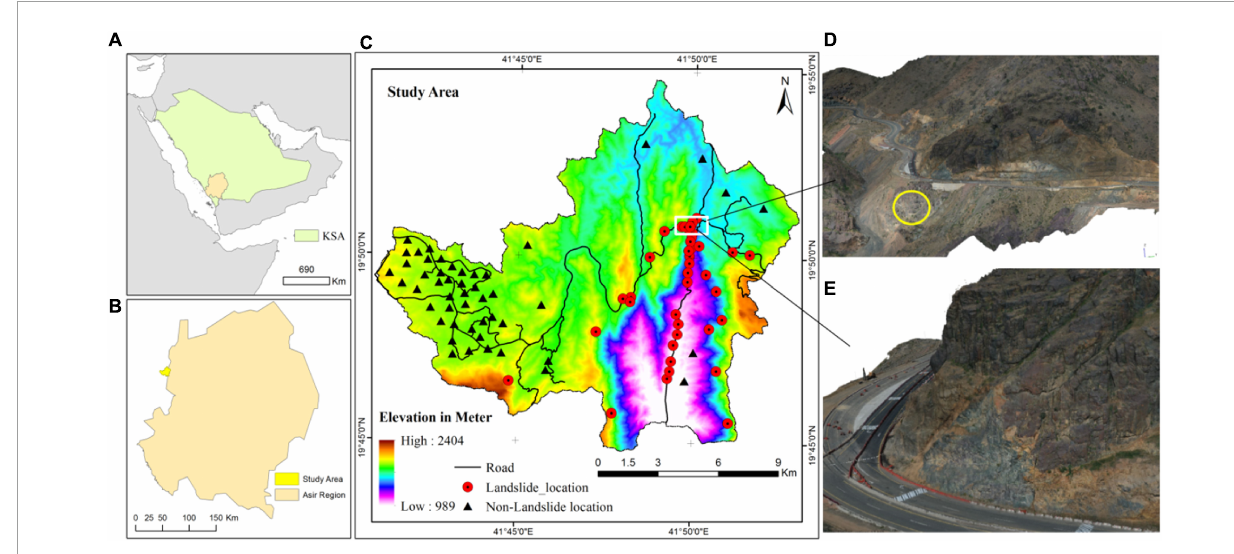
FIGURE1 Showing the study area, landslide sites (A) Saudi Arabia with Asir region; (B) Asir region with the study area location; (C) the study area, landslide site and non-landslide site and (D,E) 3D model of landslide site (white circle showing landslide-prone area).